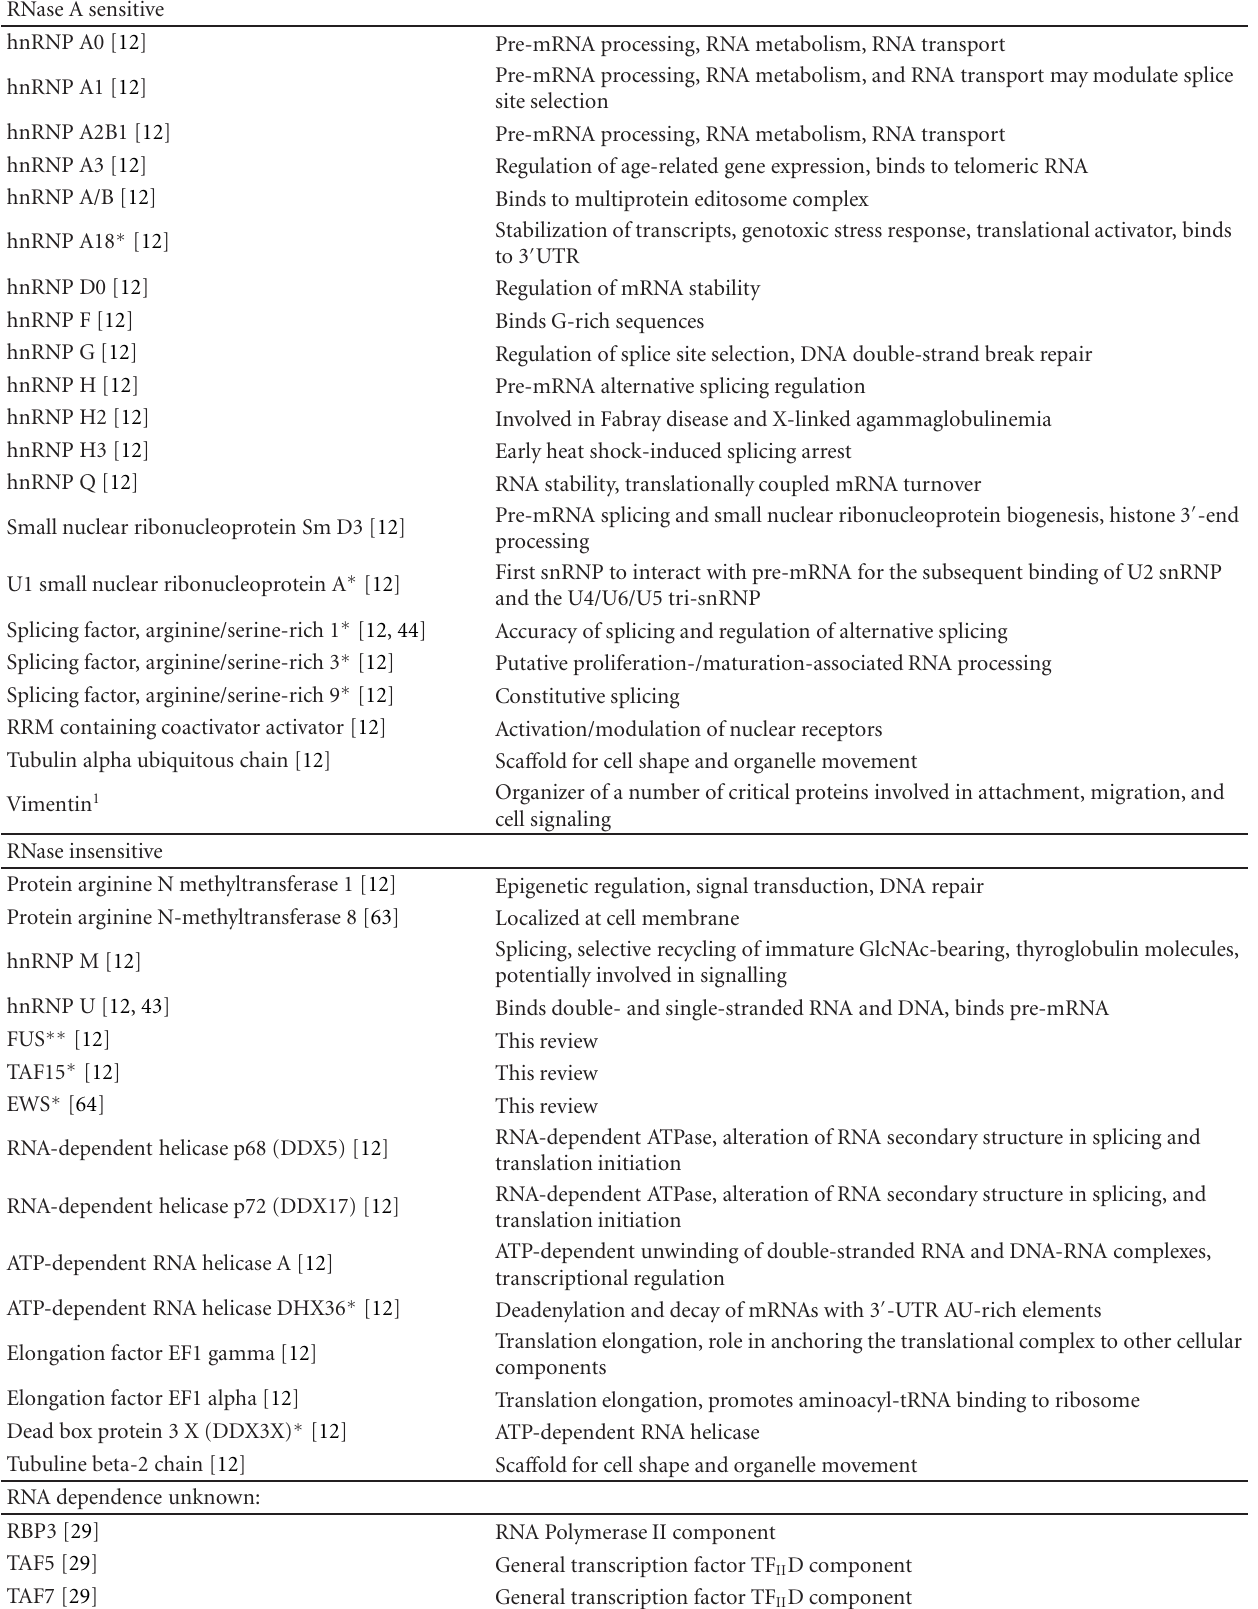
Table 1: EWS interacting proteins: ∗ not bound by methylated EWS; ∗∗ not bound by methylated EWS upon RNaseA treatment. RNase A